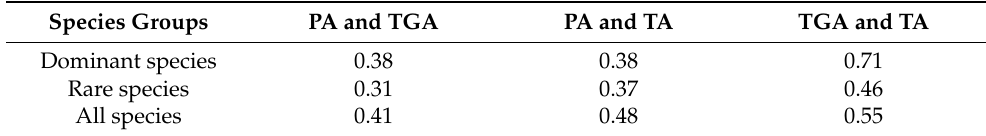
Table 4. Comparison of community similarity among different plant species groups at three sites subject to different levels of disturbance within the KGTA and YWNR, Beijing Municipality, China. Species Groups PA and TGA PA and TA TGA and TA Dominant species 0.38 0.38 0.71 Rare species 0.31 0.37 0.46 All species 0.41 0.48 0.55